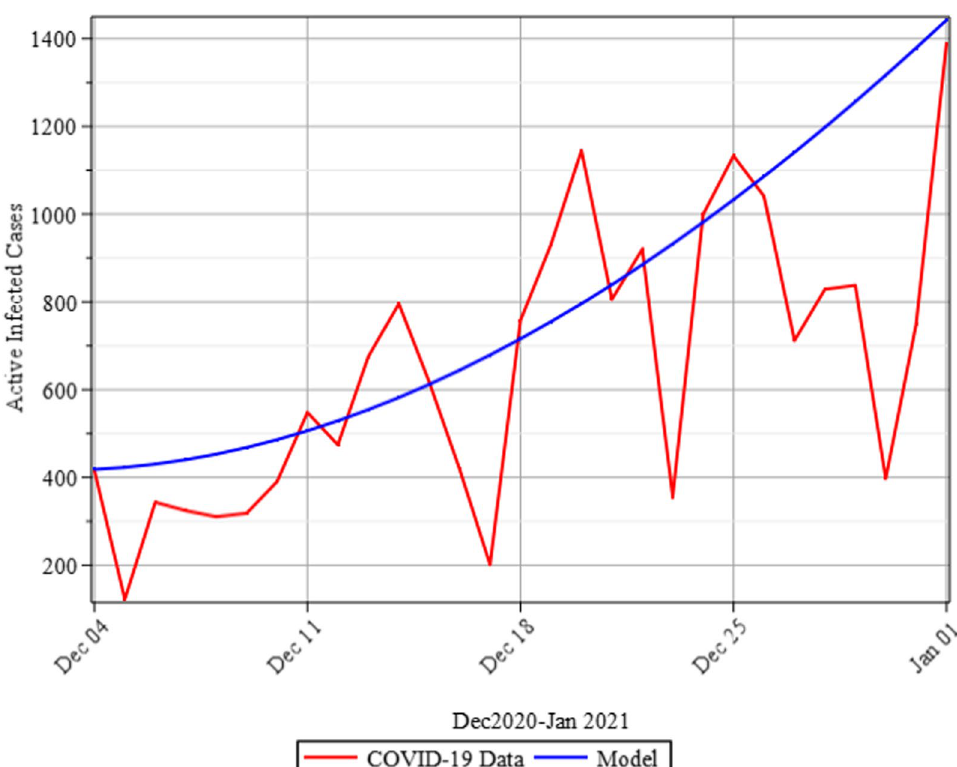
Fig. 11 Comparison plots of real-life COVID-19 data and the model’s simulation